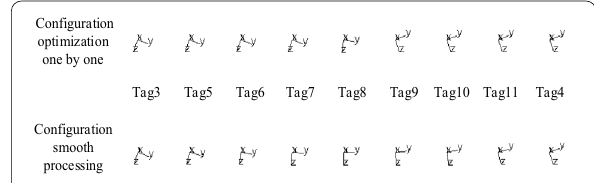
Figure 26 Optimized posture comparison between smoothing processing and configuration